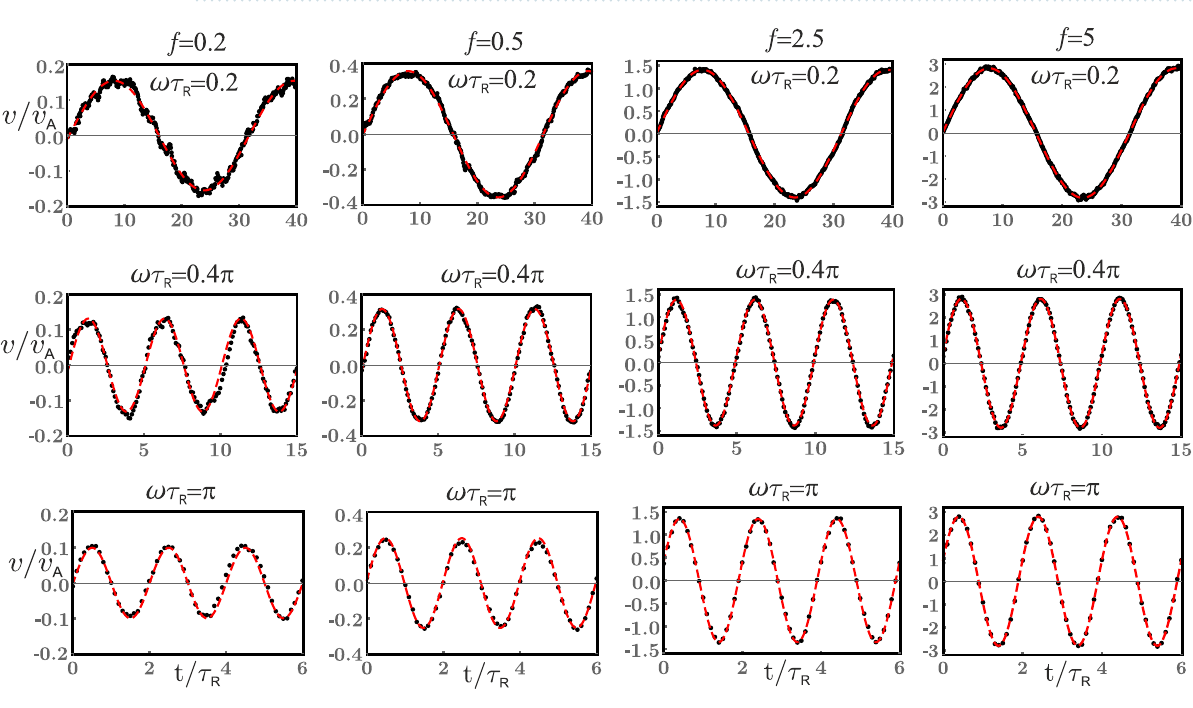
Figure 4. The absolute values of average forces of the tracer, respectively, as a function of the external force f for an active bath characterized by ( a ) Pe 240 . The insets show the difference ( b ) Pe =